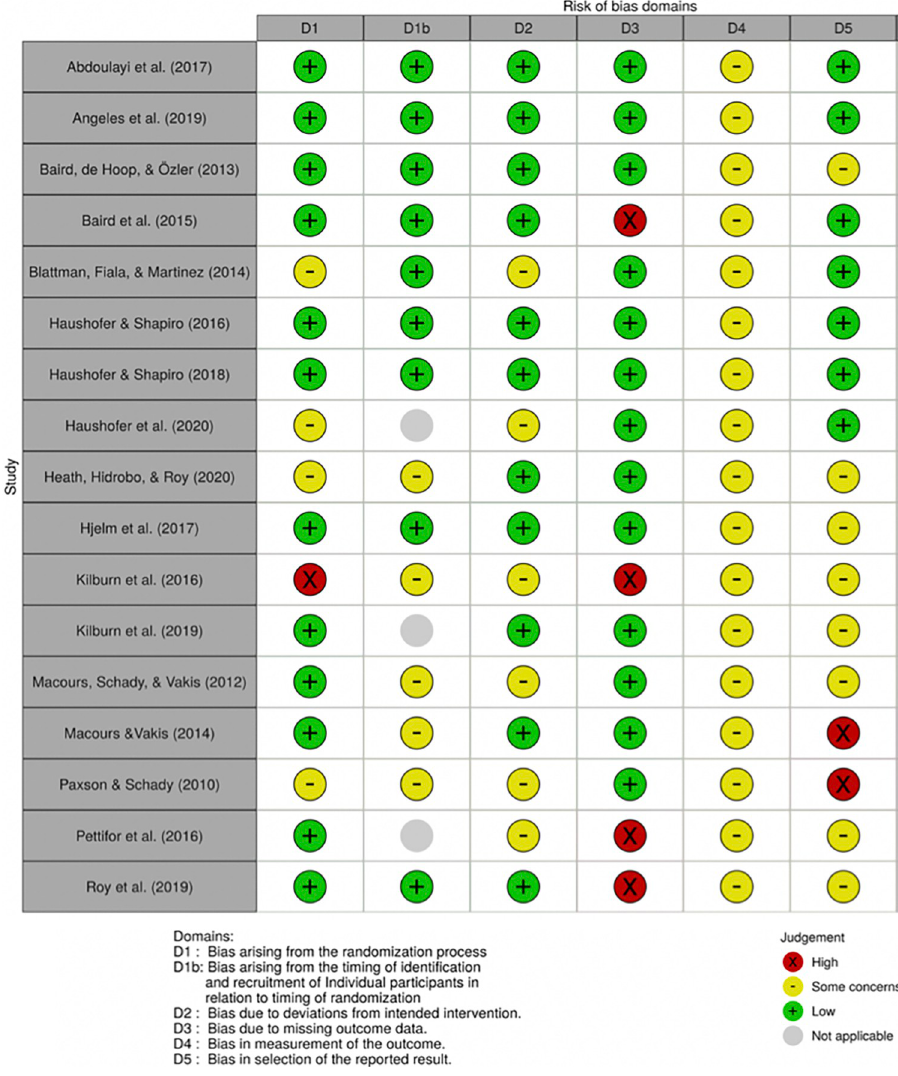
Fig 2. Risk of bias per